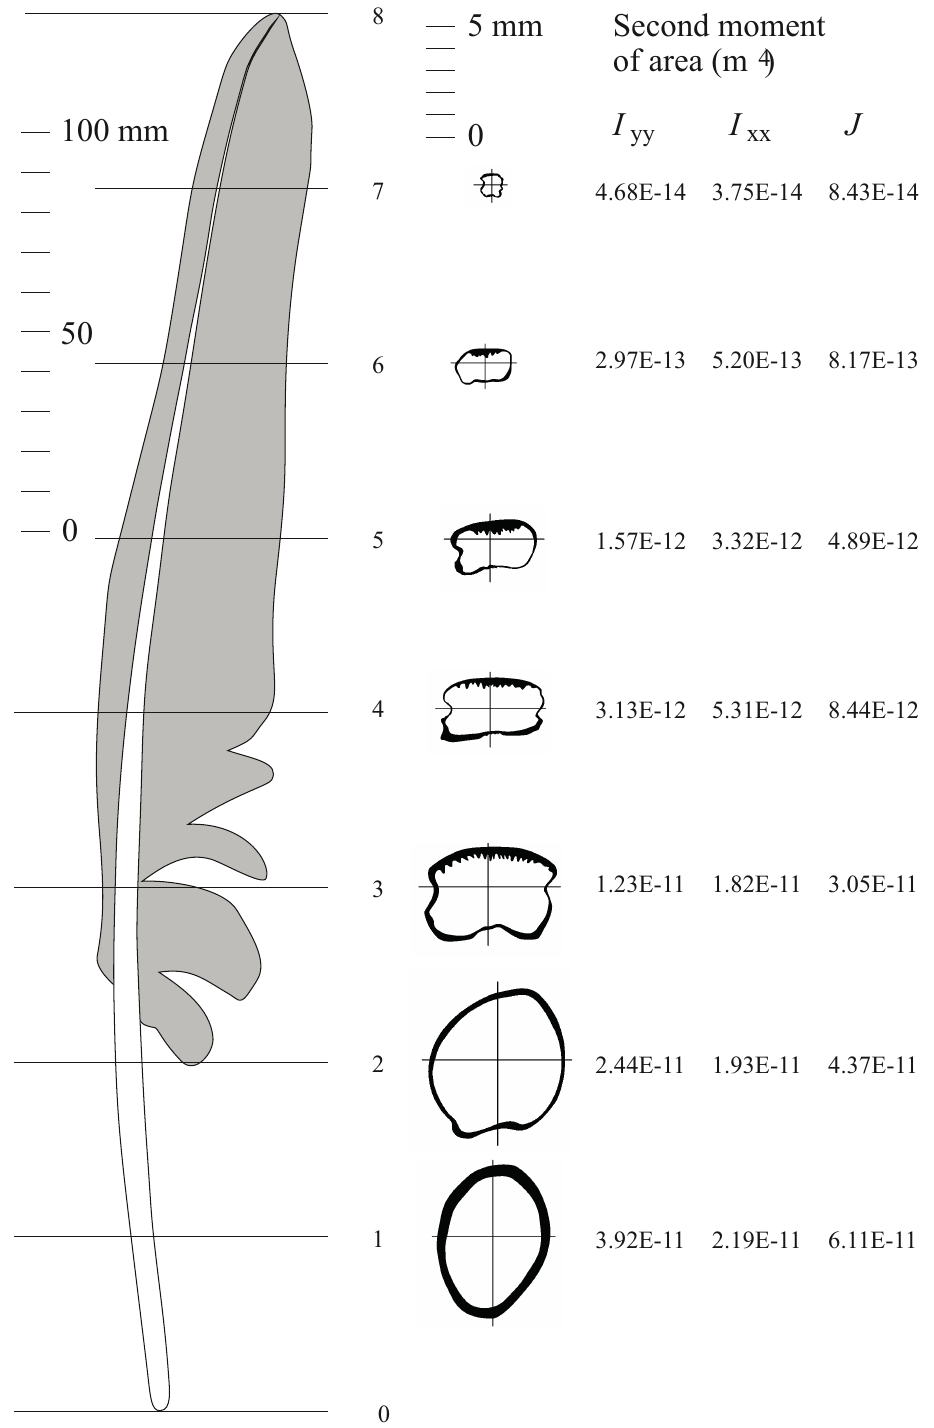
Figure 7. The shaft of a Greylag Goose secondary flight feather is made of keratin, and has a second moment of area that carries the bending and torsional loads of that feather (not of other feathers). The late-Jurassic Archaeopteryx fossils had wing feathers exactly like this, showing that the bird wing was developed in Jurassic times. This was about 110 million years before the extinction of the pterosaurs, which had no such